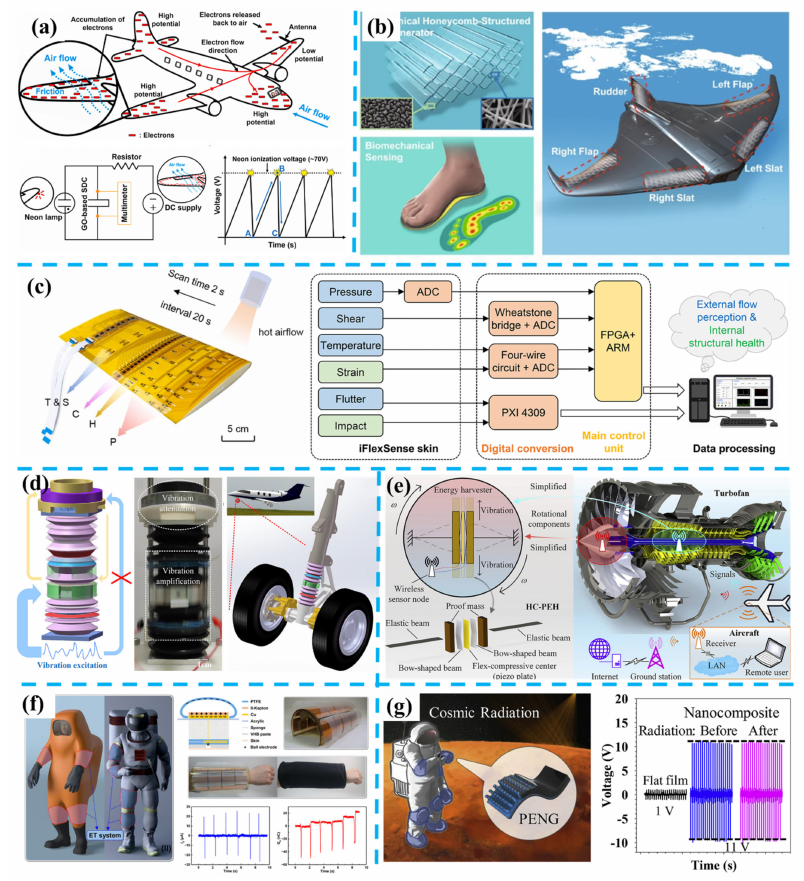
Figure 10. Aircraft and aerospace. ( a ) Aviation static electricity harvesting and storage for the aircraft (Reprinted with permission from ref. [312]. Copyright 2020 Elsevier). ( b ) Morphing wing energy harvesting (Reprinted with permission from ref. [313]. Copyright 2021 Springer). ( c ) In- telligent flexible sensing (iFlexSense) skin for multifunctional flying perception (Reprinted with permission from ref. [314]. Copyright 2021 Elsevier). ( d ) Vibrational energy harvesting enhanced by energy transfer and redistribution in the landing gear of a plane (Reprinted with permission from ref. [315]. Copyright 2020 Elsevier). ( e ) Energy harvesting for jet engine monitoring (Reprinted with permission from ref. [316]. Copyright 2020 Elsevier). ( f ) Self-powered electro-tactile system for spacesuit (Reprinted with permission from ref. [317]. Copyright 2021 Science). ( g ) High-performance piezoelectric nanogenerator for energy harvesting and radiation protection in space (Reprinted with permission from ref. [318]. Copyright 2019